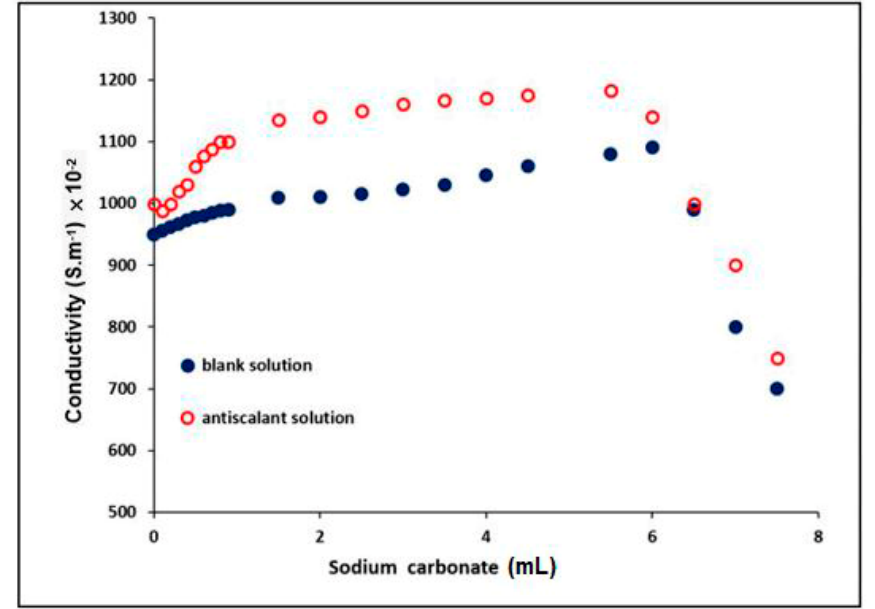
Figure 8. Variation in the conductivity in the presence and absence of 10 mg·L − 1 CA-co-GLC at 25 °C and pH 8.5.